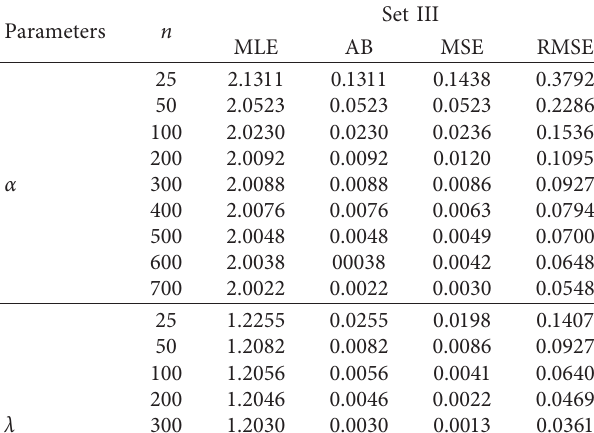
Table 4: Monte Carlo simulation results for the AT-W distribution using Set III values ( α � 2.0 and λ � 1.2).